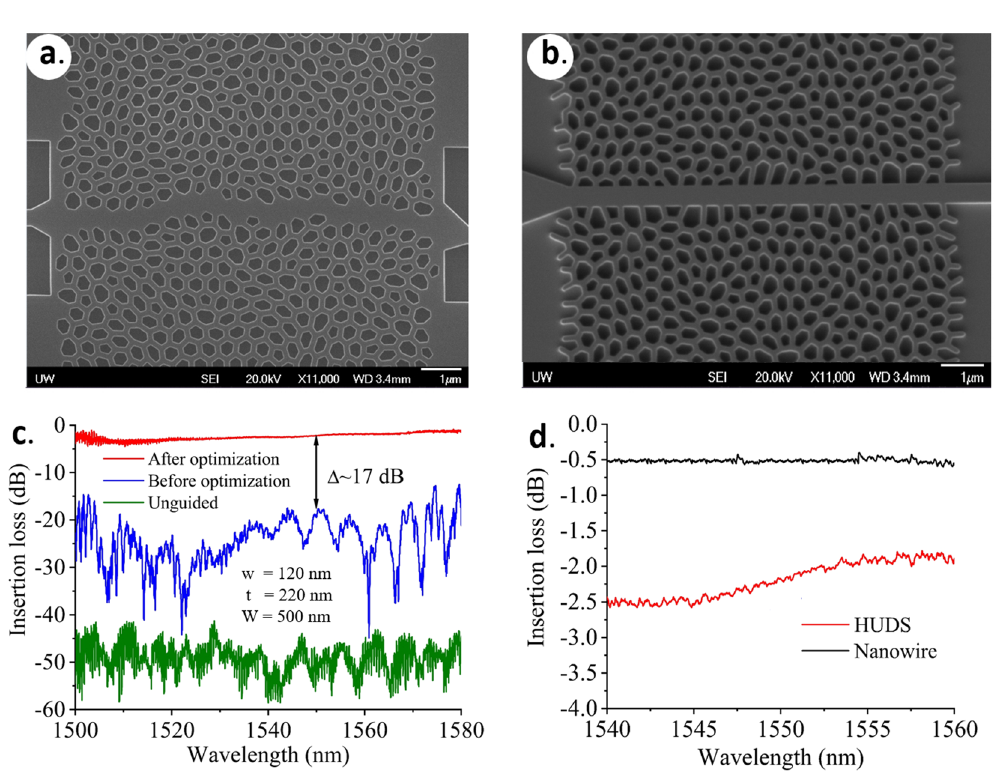
Figure 3. ( a ) SEM image of a fabricated SOI HUD waveguide by simply skipping a row of etched air holes. ( b ) SEM image of a fabricated SOI HUD waveguide (including design optimization). ( c ) Experimentally measured transmission spectrum comparing performance of HUD waveguide before ( a ) and after ( b ) design optimization shows a 17 dB improvement. A flat transmission spectrum across a large range was achieved after waveguide optimization. ( d ) Experimentally measured transmission spectrum comparing the coupling losses of the optimized HUD waveguide and a silicon strip waveguide. Insertion losses of ~2–3 dB were obtained due to the input/output coupling loss between HUD waveguide and the rest of the devices. Here, w represents the uniform width of the network walls, t is the waveguide thickness (height), and W is the average cell separation and also the fixed width of the waveguide channel in ( b ). The label ‘unguided’ in Fig. 3(c) refers to the HUDS structure without a waveguide channel embedded in